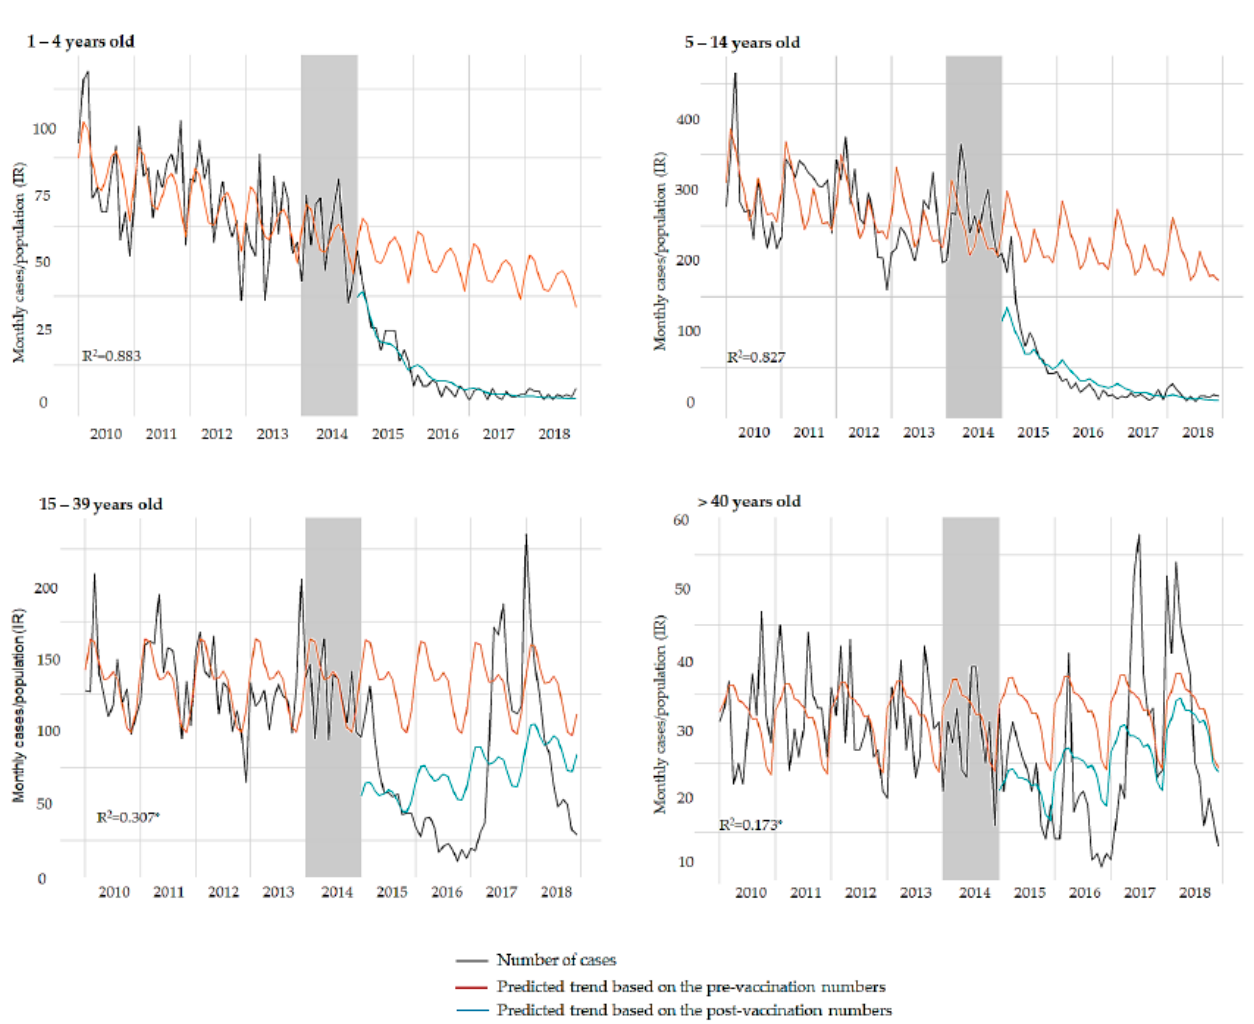
Figure 2. Trends in monthly number of hepatitis A cases over the study period for each age group. Grey bars represent the year of hepatitis A vaccine introduction (transition period). * Model affected by the outbreak. Table 2. Time-series model estimates of the impact of hepatitis A vaccination on yearly cases number, by age group.